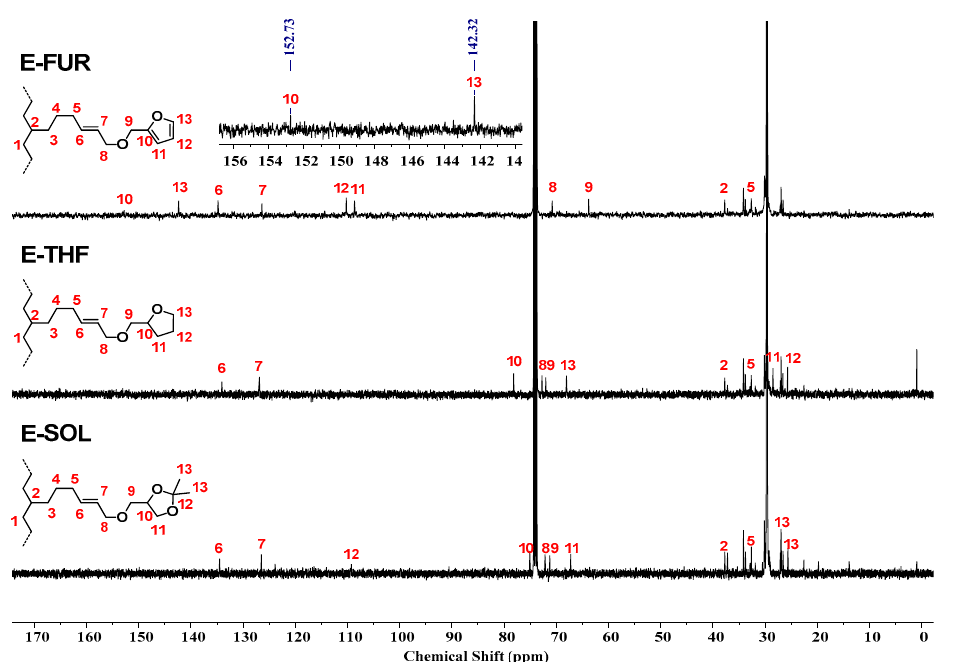
Figure 2. 13 C NMR spectra of ethylene and 2,7-octadienyl ether copolymers ( E-FUR , Table 1, entry 3; E-THF , Table 1, entry 4; E-SOL , Table 1, entry 15).